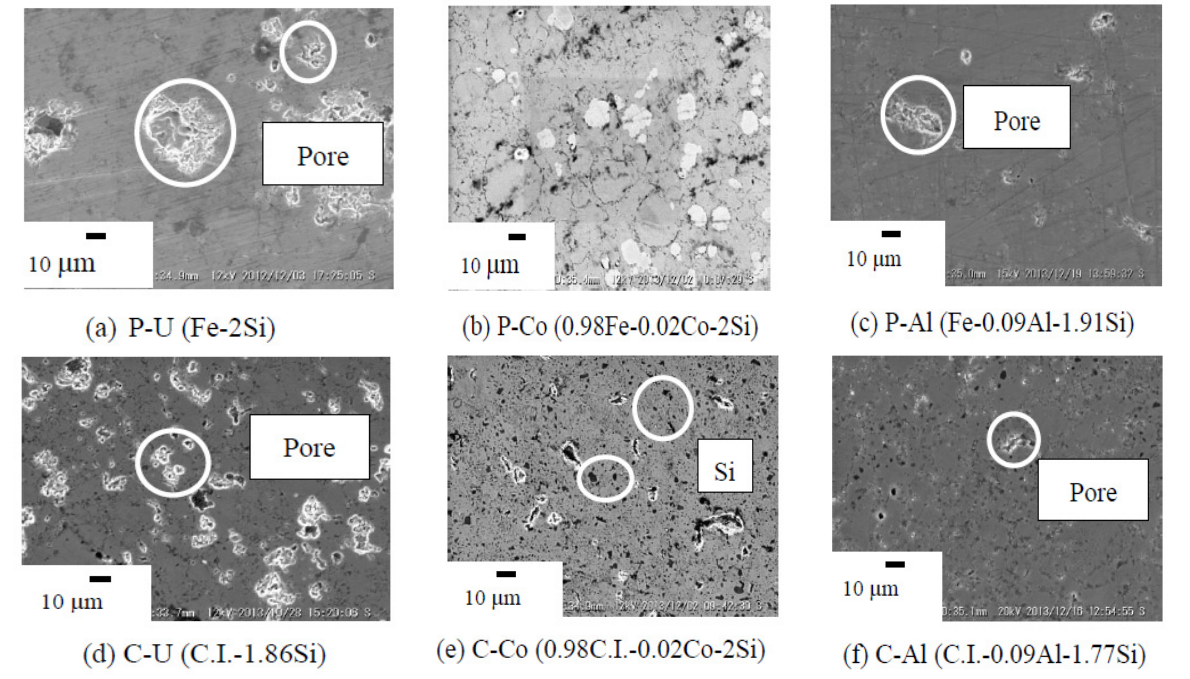
Table 2. Porosity data for the sintered β -FeSi